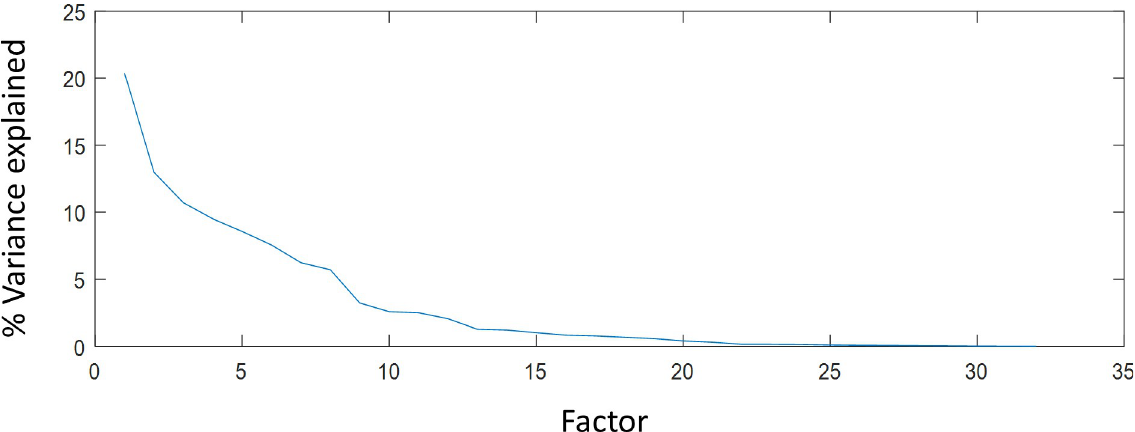
Fig 4. The proportional variation in the summed data of all subjects that can be explained by each factor, sorted by the amount of variance explained.